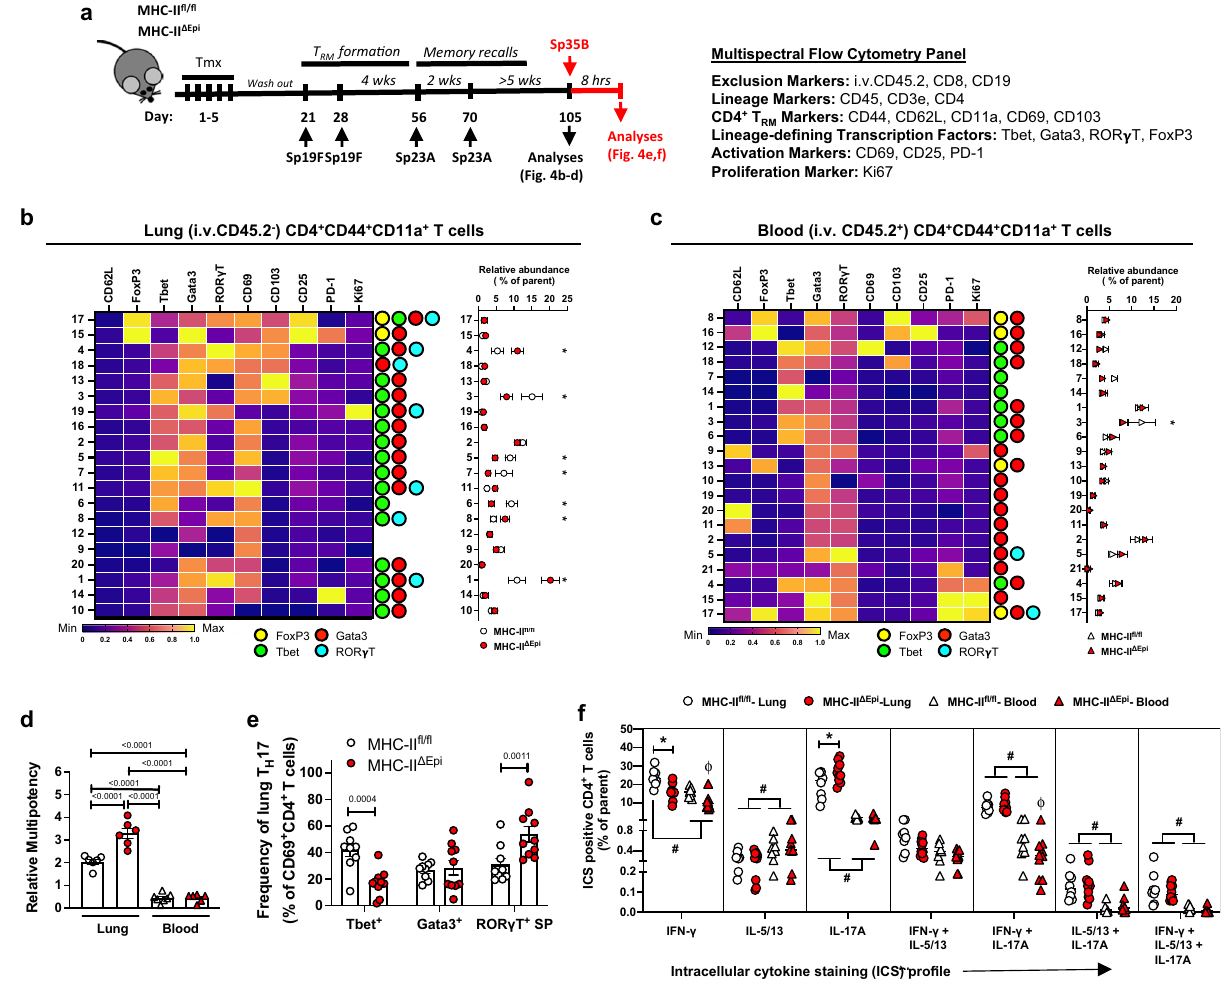
Fig. 4 LEC MHC-II directs CD4 + T RM cell activities. a Schematic of experimental timeline and antibody panel used. b Left: Heat map depicting normalized expression levels of distinct molecules on lung (i.v.CD45.2 − ) memory (CD44 + CD11a + ) CD4 + T cells clusters on day 105. The lineage determining transcription factor (LDTF) status of each cluster is depicted. Right: Relative abundance of each cluster at day 105 in MHC-II fl / fl and MHC-II Δ Epi lungs. Two-way ANOVA with two-stage step-up method of Benjamini, Krieger, and Yekutieli to correct for multiple comparisons. FDR p value: * ≤ 0.05. c Left: Heat map depicting normalized expression levels of distinct molecules on blood intravascular (i.v.CD45.2 + ) memory (CD44 + CD11a + ) CD4 + T cell clusters on day 105. LDTF status of each cluster is depicted. Right : Relative abundance of each cluster at day 105 in MHC-II fl / fl and MHC-II Δ Epi lungs. Two- way ANOVA with two-stage step-up method of Benjamini, Krieger and Yekutieli to correct for multiple comparisons. FDR p value: * ≤ 0.05. d Relative multipotency indices for memory (CD44 + CD11a + ) CD4 + T cells in lung ( circle ) and blood ( triangles ) of MHC-II fl / fl ( white ) and MHC-II Δ Epi mice ( red ) at day 105, One-way ANOVA with Holm-Sidak ’ s multiple comparison test. e Frequency of activated (CD69 + ) Tbet + , Gata3 + or ROR γ T single-positive (SP) T H 17 cells in MHC-II fl / fl and MHC-II Δ Epi lungs 8hpi Sp35B, Two-Way ANOVA with Fisher ’ s LSD test. For all experiments, positivity for a LDTF was determined using cutoffs identi fi ed from clusters negative for that LDTF. f Intracellular cytokine staining (ICS) pro fi le of lung (i.v.CD45.2 − ) and blood (i.v.CD45.2 + ) CD4 + T cells isolated from lungs on day 105 and stimulated with PMA/Ionomycin ex vivo, two-way ANOVA with Geisser-Greenhouse correction and two-stage step-up method of Benjamini, Krieger, and Yekutieli to correct for multiple comparisons. p value: # ≤ 0.05 comparison between lung and blood; * ≤ 0.05 genotype-dependent comparison within lungs; Φ ≤ 0.05 genotype-dependent comparison within blood. All data have n ≥ 6 mice, two independent experiments. All data are presented as mean ± SEM. infections mimic homeostatic nonlethal inhalation of microbes to CD4 + T RM cell numbers on day 105 revealed comparable which adult lungs would already possess CD4 + T RM cells. Mea- frequencies between genotypes (Supplementary Fig. 6g). Next, we surements of airway cellularity revealed no ongoing in fl ammation used Phenograph to identify distinct clusters of CD4 + T cells based on unique expression pro fi les, and quanti fi ed their relative as evidenced by <1% neutrophil content of the bronchoalveolar abundance in genotype-dependent fashion. Phenograph cluster- deletion of LEC MHC-II was con fi rmed (Supplementary Fig. 6f). To examine CD4 + T RM phenotypes in the absence of LEC MHC-II, we used a 21-parameter high-dimensional MSFC panel (Supplementary Fig. 7a), none being unique to either genotype including antibodies to CD4 + T RM markers, T cell lineage- and all being negative for CD62L. For further analyses, we focused on the 20 clusters at >0.5% frequency (Fig. 4b). de fi ning transcription factors (LDTFs), and markers of activation Remarkably, 17 of the 20 memory CD4 + T cell clusters and proliferation (Fig. 4a). Analysis of total lung CD4 + T cell and NATURE COMMUNICATIONS| (2021) 12:5834